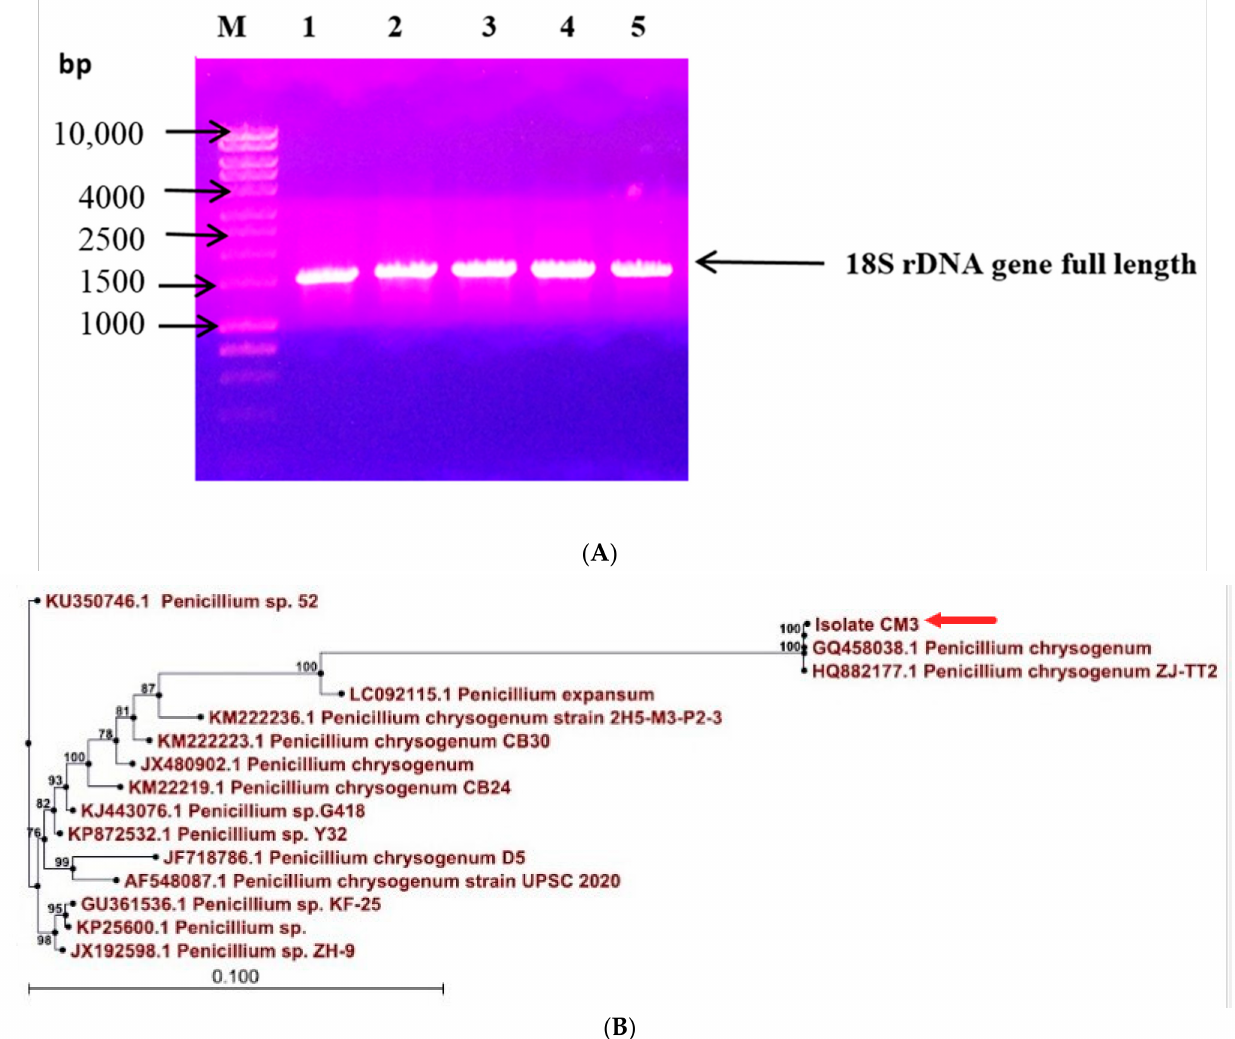
Figure 1. ( A ) Agarose gel (1% w / v ) electrophoresis showing the PCR product for the full length 18S rDNA gene amplified by PCR from the quest fungal strain. M: 1kbp DNA ladder. Lanes 1–5: amplified PCR product of 18S rDNA full length from the quest fungal strain from five PCR reactions Eppendorf tubes. ( B ) Neighbor-joining tree (constructed by CLC Sequence Viewer 8.0) depicting the phylogenetic relationship between 18S ribosomal DNA sequence of the Figure 3, (the fungal isolate in this study) and other 18S ribosomal DNA sequences assigning to closely related fungi. Bootstrap values were presented on branch nodes (100 re-samplings). The fungal isolate CM3 is the quest fungal strain P. chrysogenum strain A3 DSM105774 and is indicated by a red